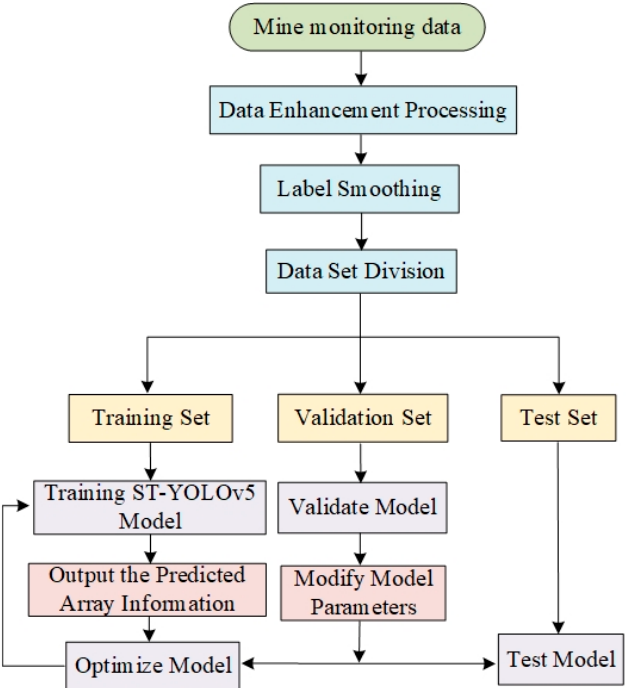
Figure 10. ST-YOLOv5 model object detection process.